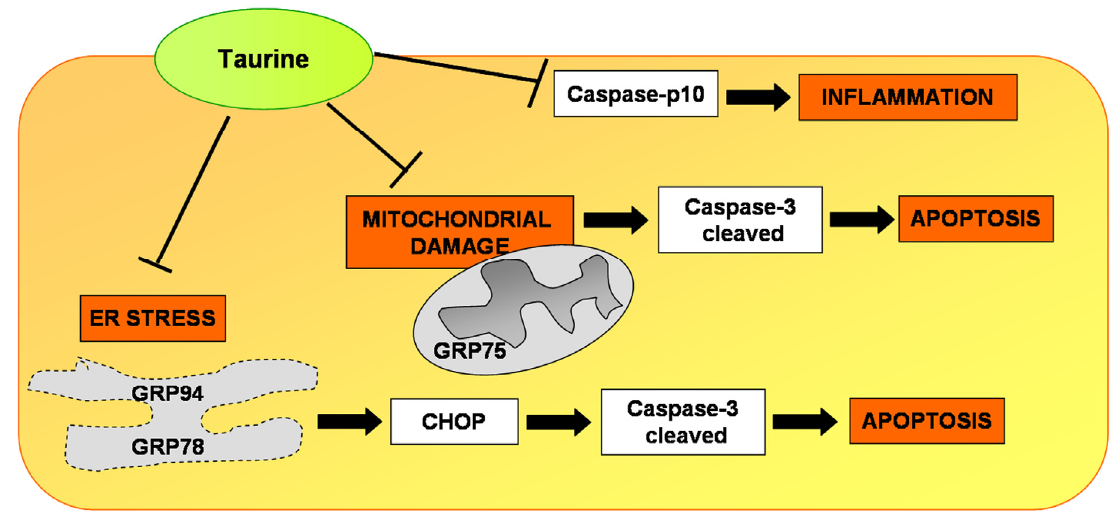
Figure 7. Potential protective effects of dietary taurine in puromycin aminonucleoside nephrosis in rats . Endoplasmic reticulum stress and mitochondrial-related apoptosis were limited by taurine inhibition of CHOP and activated cleaved caspase 3. T-bars indicate inhibition, and arrows indicate activation. (ER): endoplasmic reticulum; (CHOP): C/EBP homologous protein.